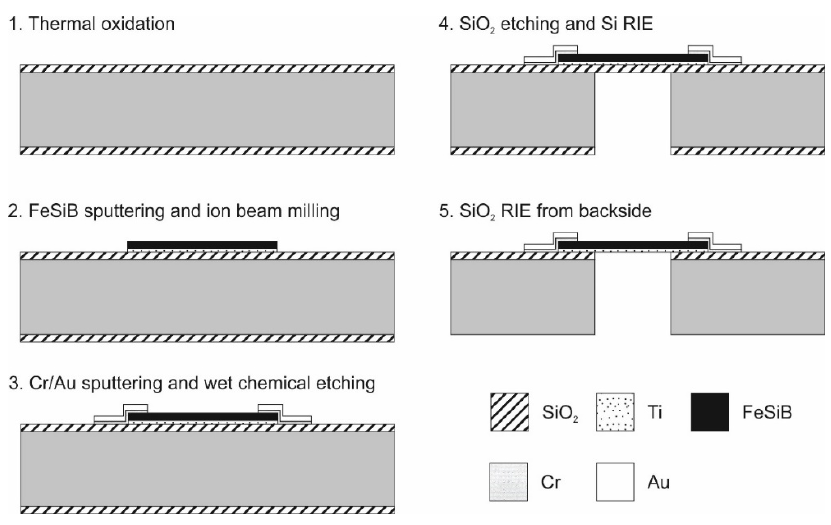
Figure 1. Process flow of the fabrication of the pressure sensor—shown by its cross-section.